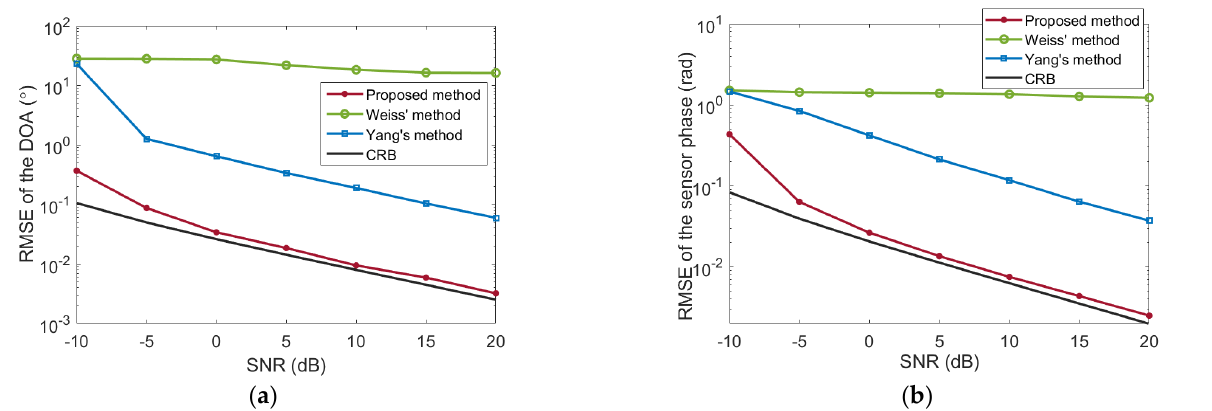
Figure 4. RMSEs versus SNRs: ( a ) DOA estimation; ( b ) DD sensor phase estimation.